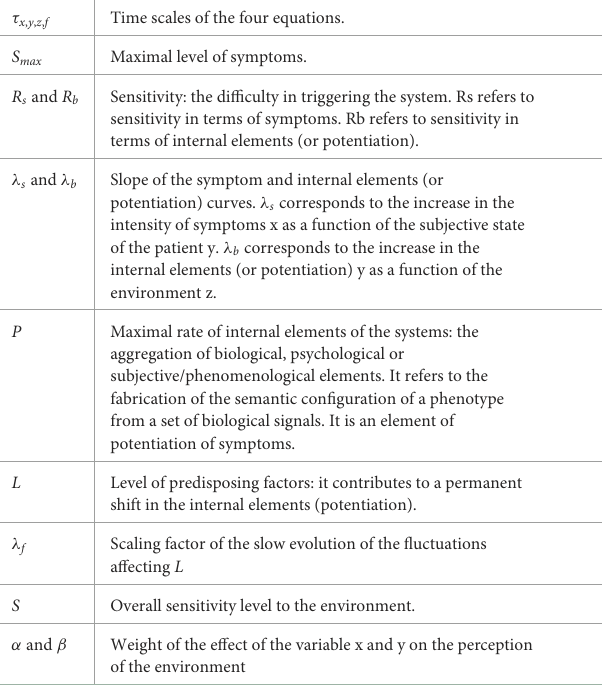
TABLE 1 Description of the parameters of the toy-model. τ x , y , z , f Time scales of the four equations. S max Maximal level of